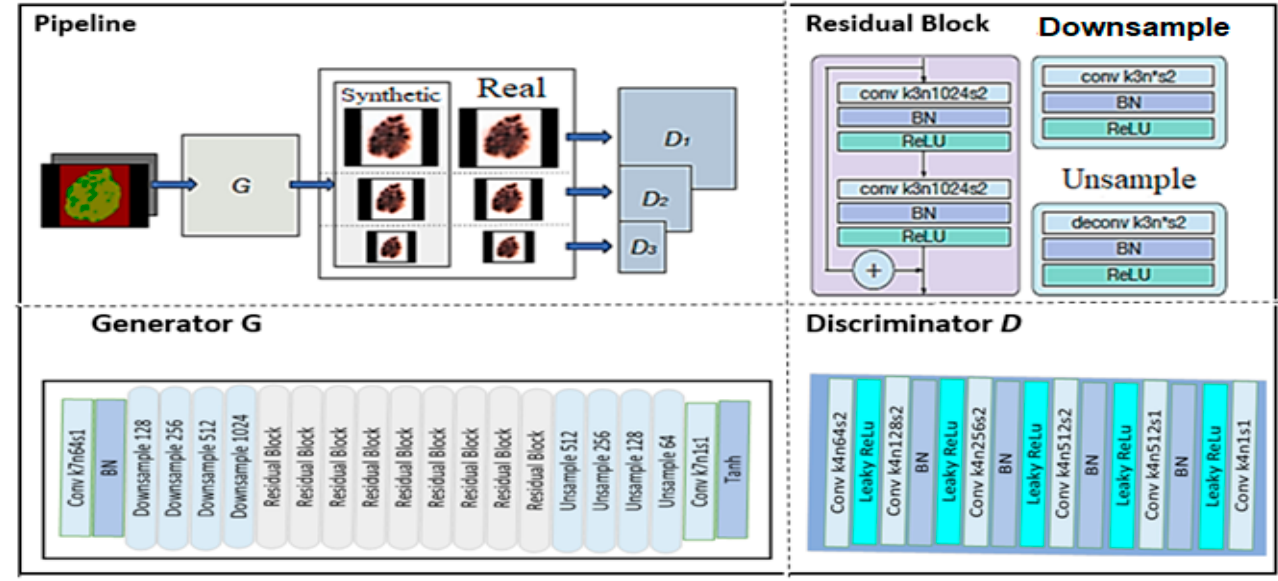
Figure 8. GAN architecture [64].